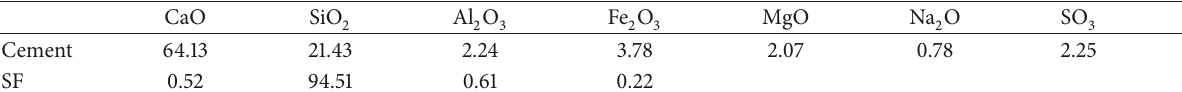
Table 1: Chemical composition of experiment materials%.